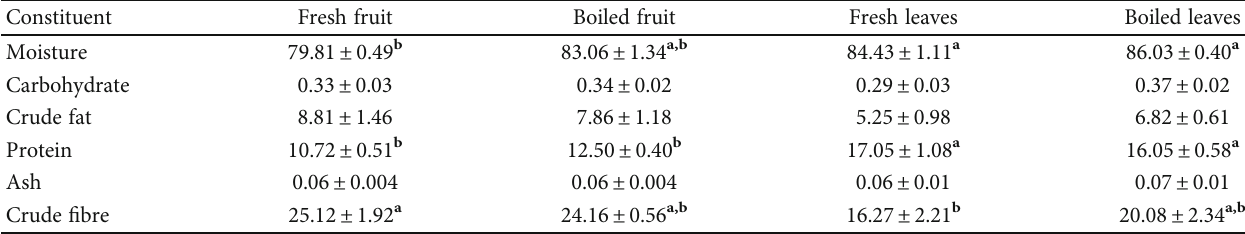
Table 3: Mean ± SE Nutritional composition (%) of Solanum torvum.